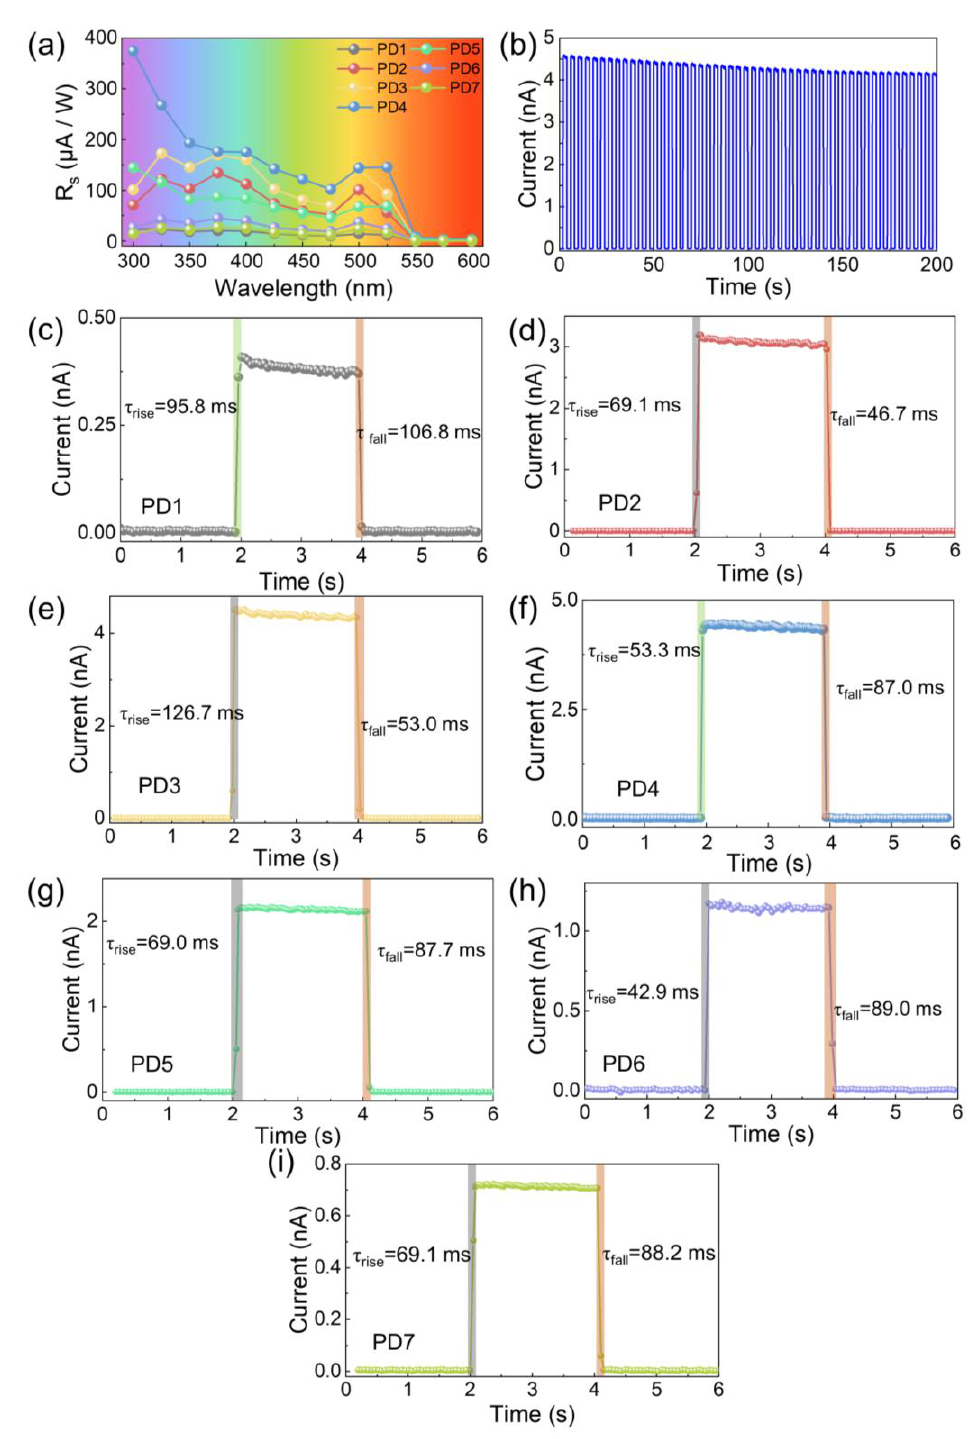
Figure 4. ( a ) The responsivity (R s ) of the photodetectors within a broadband spectrum wavelength. ( b ) Transient response of the device PD4 within multiple test cycles. Single-period response of the photodetectors ( c ) PD1, ( d ) PD2, ( e ) PD3, ( f ) PD4, ( g ) PD5, ( h ) PD6, and ( i ) PD7 under 500 nm light irradiation at 10 V bias voltage.